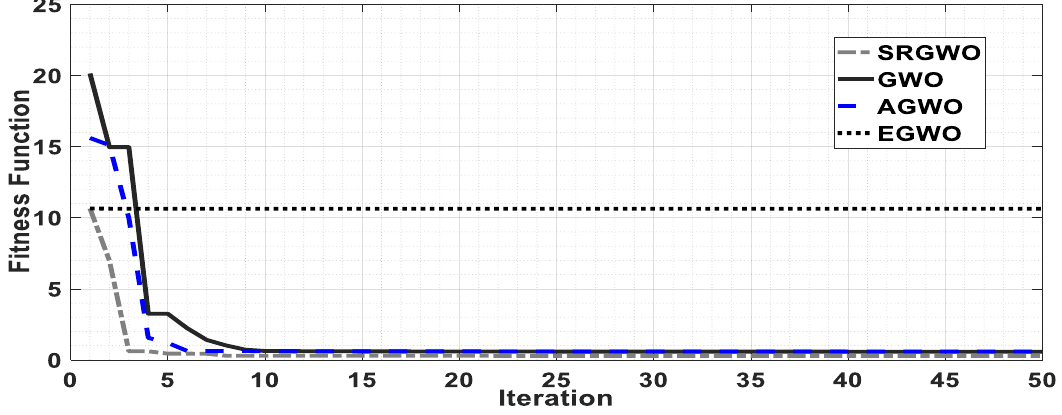
Figure 6. The convergence curves.